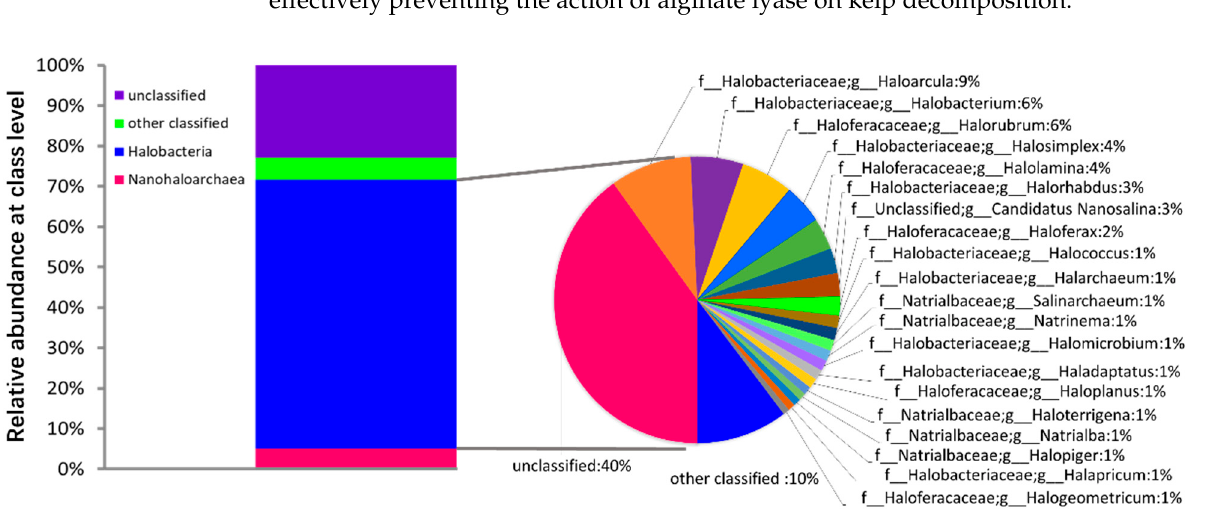
Figure 6. The microbial species annotation results of T4S10 sample